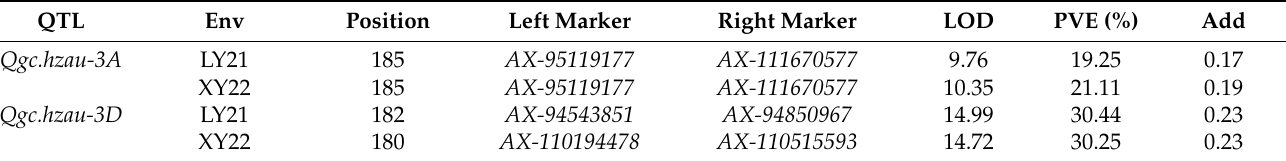
Table 4. QTLs for grain color detected by ICIM in the YM16/ZM895 DH population.